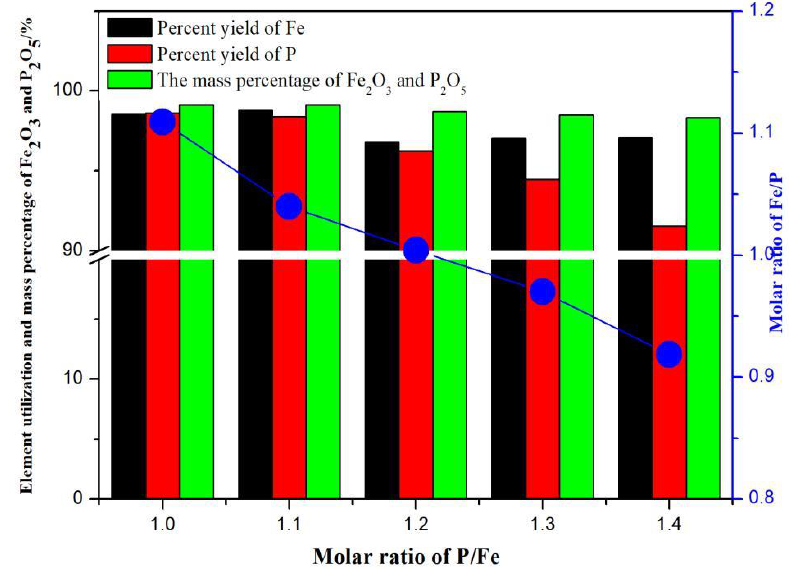
Figure 10. The e ff ect of the molar ratio of P / Fe in solution on the utilization ratio of the elements / purity Figure 10. The effect of the molar ratio of P/Fe in solution on the utilization ratio of the elements/purity and the molar ratio of Fe / P in iron and the molar ratio of Fe/P in iron phosphate.